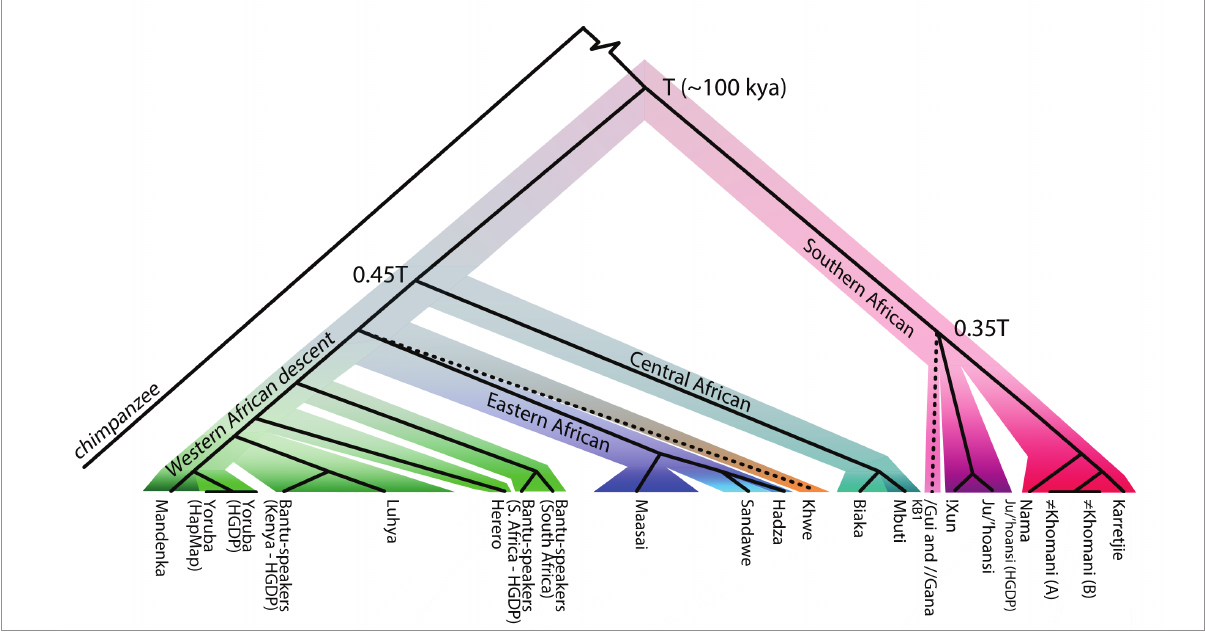
Source: Modified from Schlebusch et al. 9 Figure 2: Rooted population tree showing the genetic relationships of some sub-Saharan African